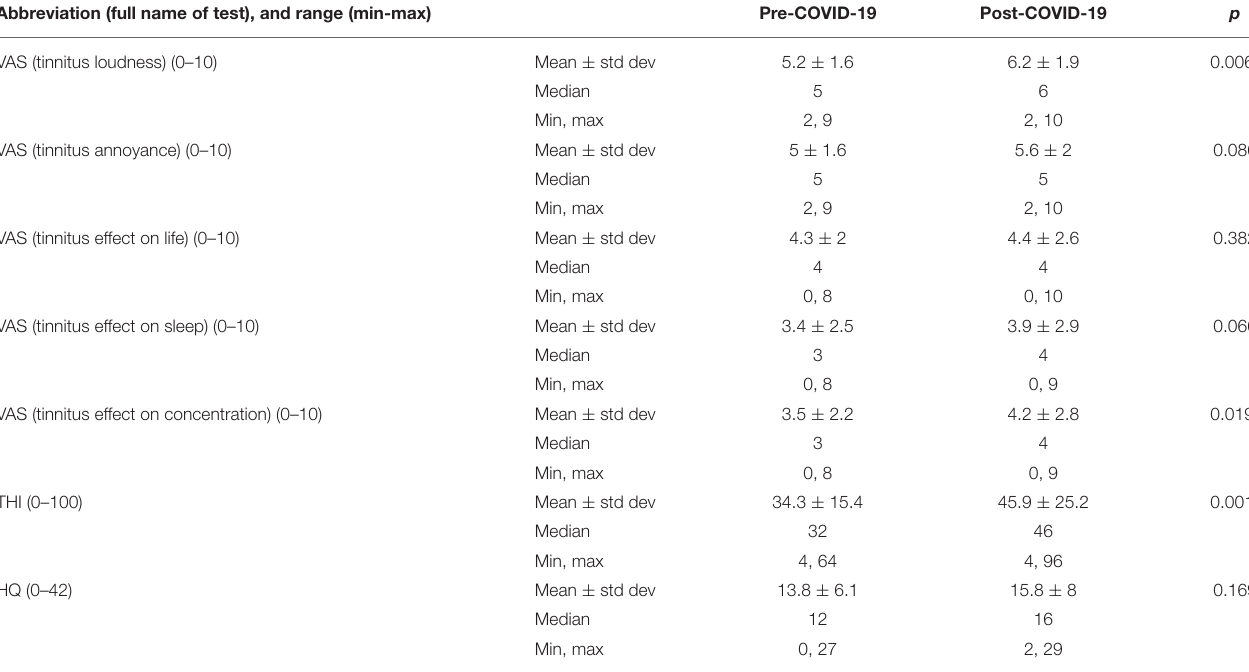
TABLE 4 | Scores of Tinnitus Handicap Inventory (THI), Hyperacusis Questionnaire (HQ), and the visual analog scales (VAS) in tinnitus patients who contracted COVID-19. Abbreviation (full name of test), and range (min-max)